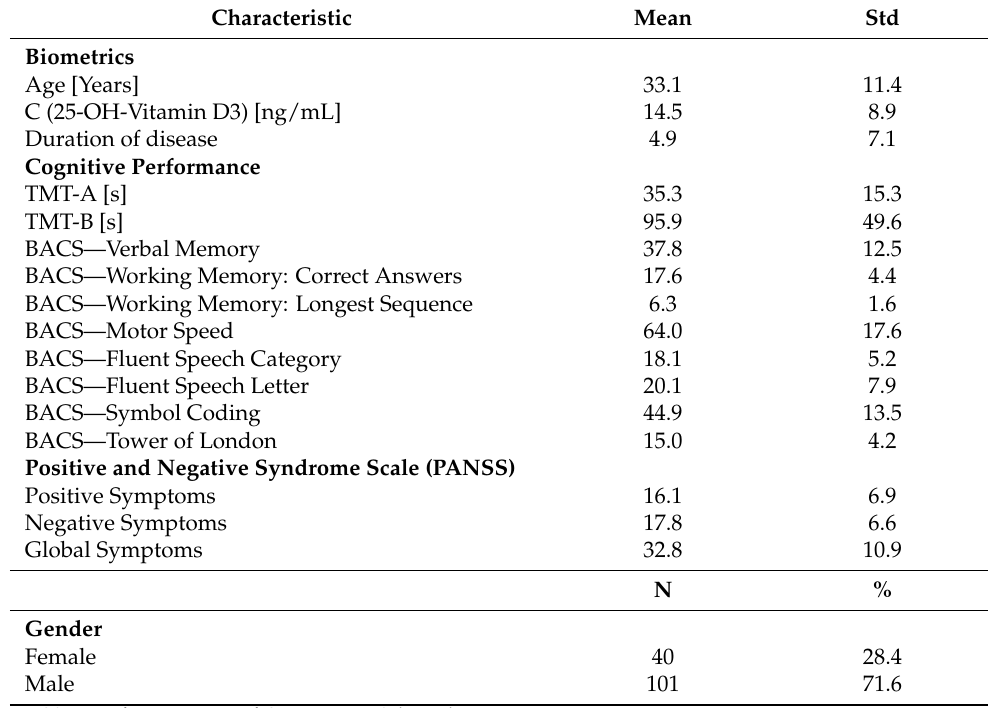
Table 1. Sociodemographic and clinical characteristics of the sample.